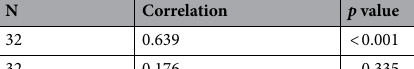
N Correlation p value Slightly beaded 32 0.639 < 0.001 “Classically” beaded 32 0.176 Table 5. Spearman’s rho correlation for inter-observer agreement of the additional ’Slightly Beaded’ and "Classically" Beaded’ categories. All analysed samples were included except DW1. Significance was set at p < 0.01.